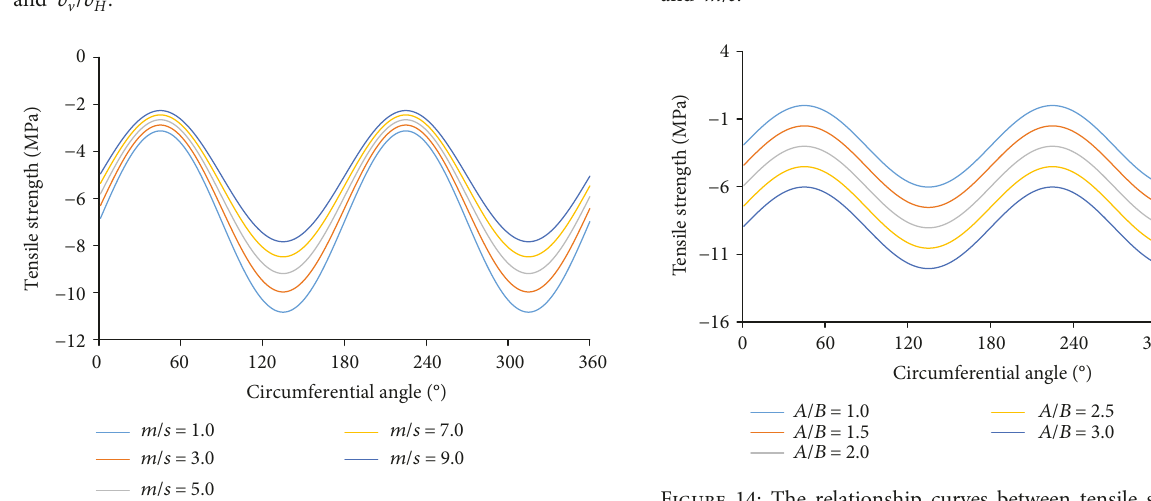
Figure 12: The relationship curves between tensile strength and circumferential angle of di ff erent m / s .